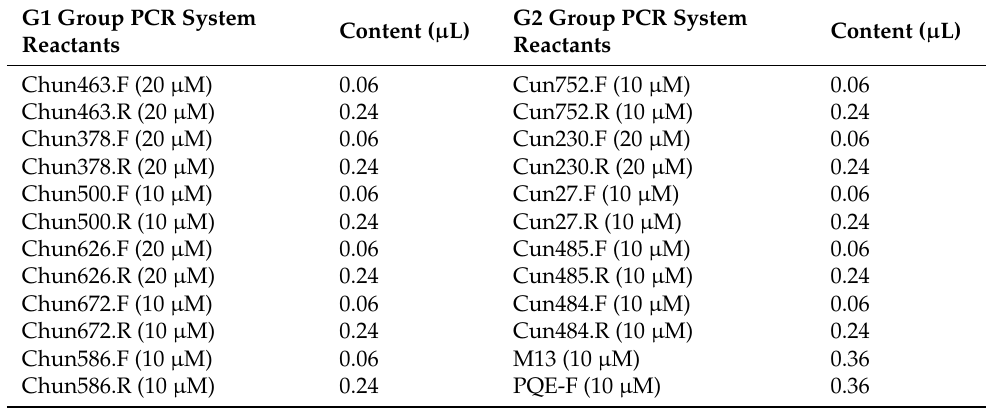
Table 2. Group G1 and Group G2 multiplex PCR reaction